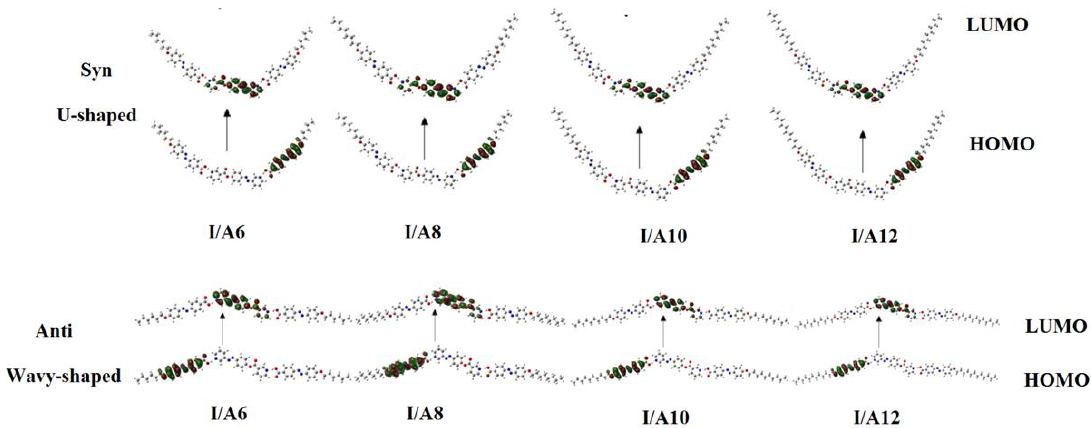
Figure 3. The estimated plots for frontier molecular orbitals of both conformers of the H-bonded complexes I/An. Table 2. FMO energies (a.u.), polarizability, α (Bohr3), and dipole moment µ (Debye) of both conformers of the supramolecular H-bonded (SMHB) complexes I/An.